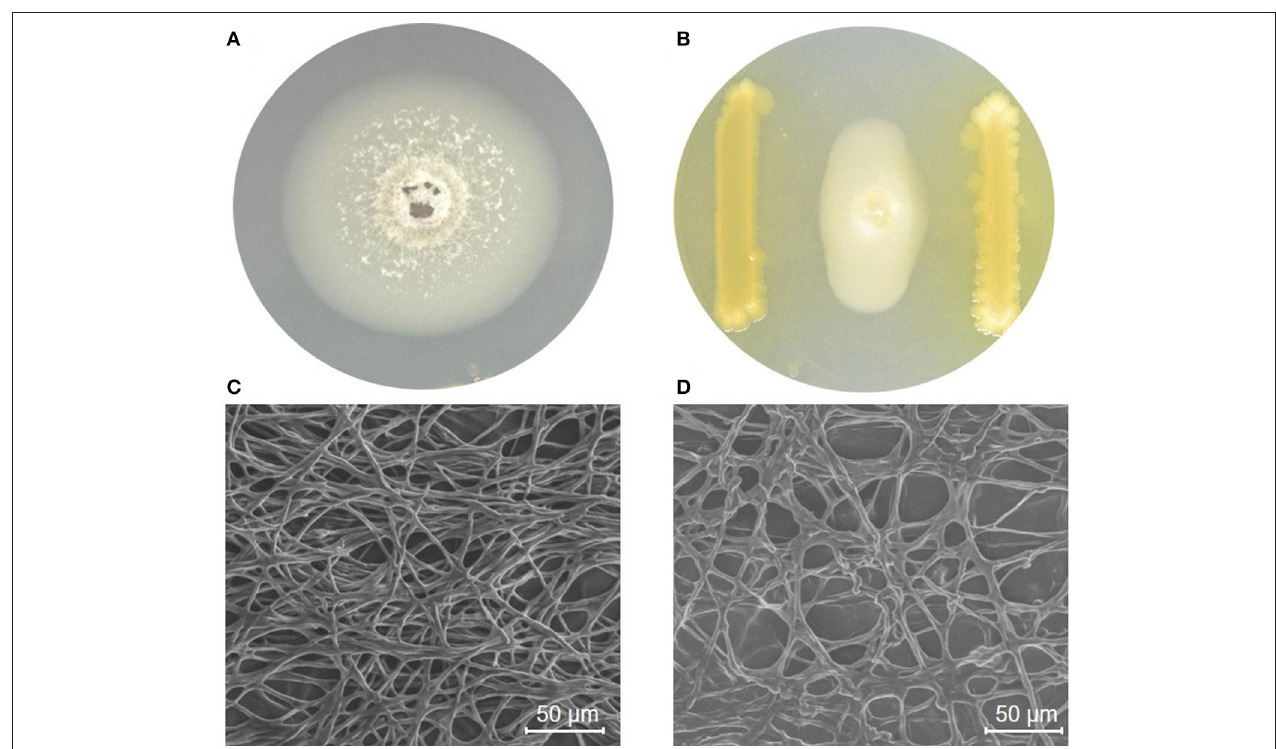
FIGURE 1 | MSSRFD41 inhibiting mycelial growth of P. grisea in a dual plate culture. (A) P. grisea control; (B) P. grisea with MSSRFD41. Scanning electron microscopic studies on the impact of MSSRFD41 on hyphae of P. grisea, (C) Control hyphae without MSSRFD41; (D) Antagonized hyphae with MSSRFD41. TABLE 1 | Antimicrobial compounds identified from Pseudomonas sp. MSSRFD41 strain through GC/MS. S.